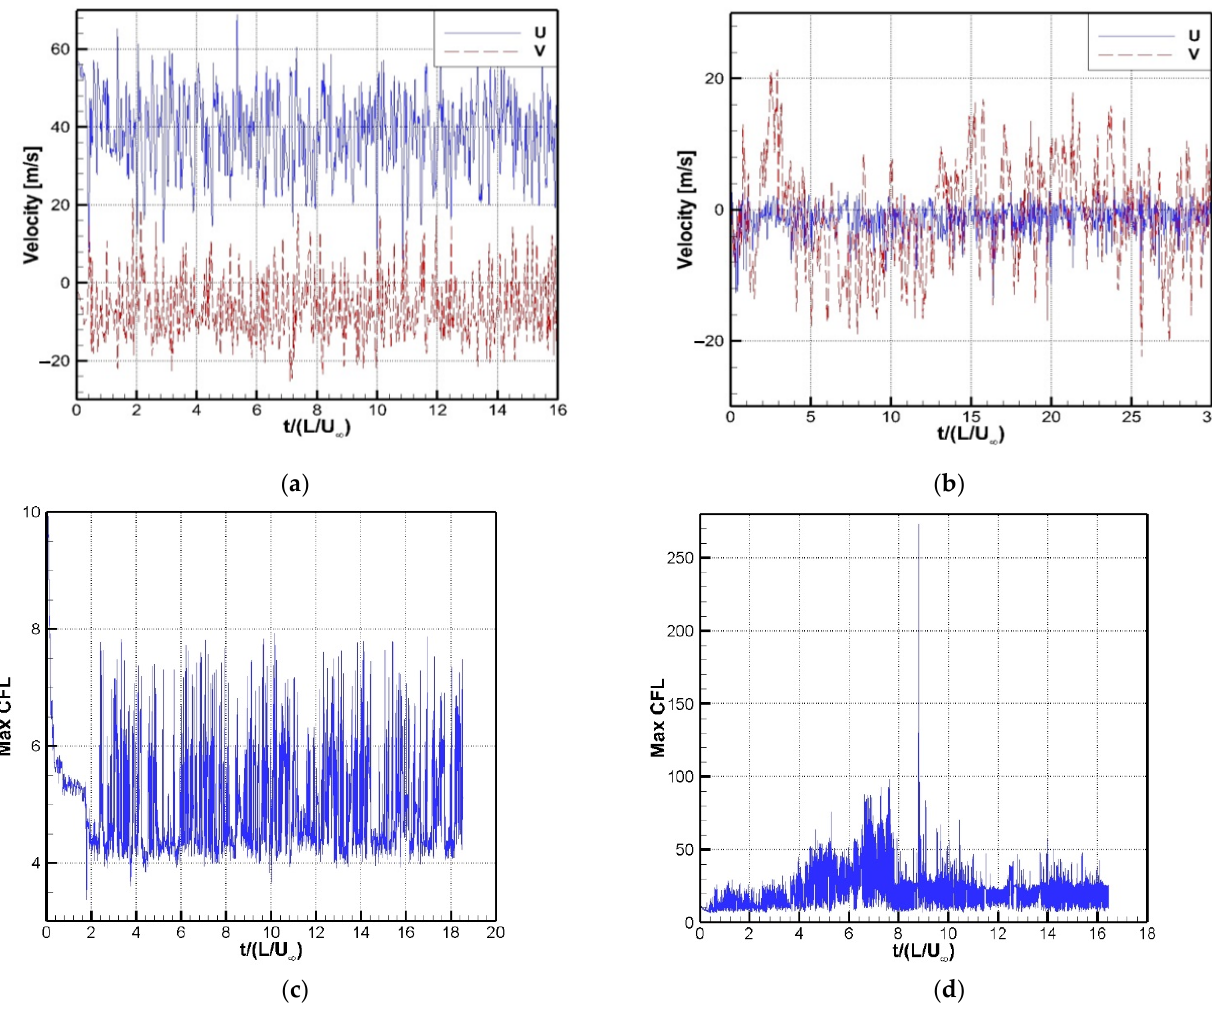
Figure 3. Time histories of velocity. ( a ) SFS2, longitudinal and lateral velocity components u and v at a middle location over flight deck at a headwind condition. ( b ) SFS2, longitudinal and lateral velocity components u and v near intersection of the flight deck and hangar aft face. ( c ) CPF, max. CFL number at Green 30°. ( d ) Canadian ship A, max. CFL at Green 30°.